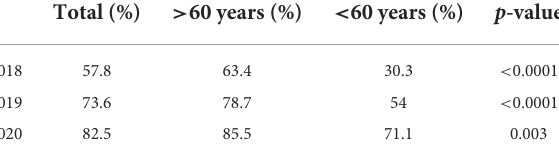
TABLE 2 People with T2D vaccinated against seasonal influenza.